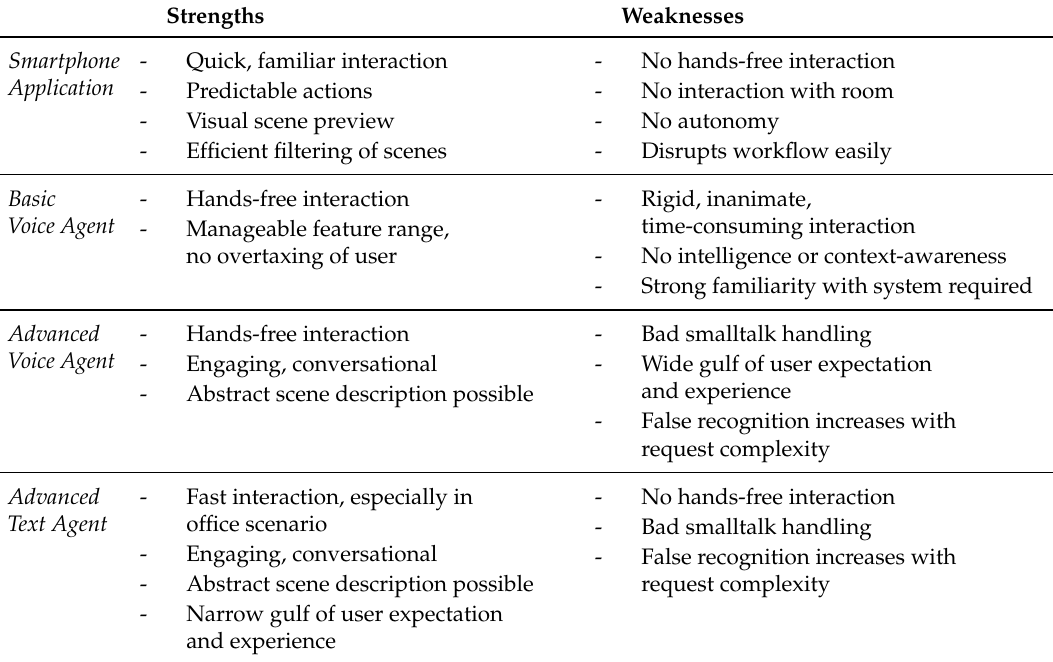
Table 4. Strengths and weaknesses for each